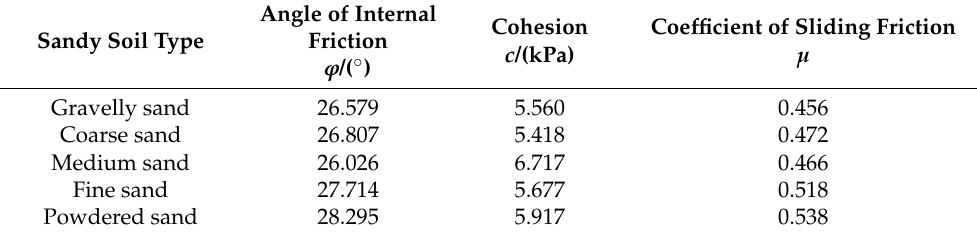
Table 5. Mechanical parameters of interface between sand with different particle sizes and steel plate. Angle of Internal Sandy Soil Type